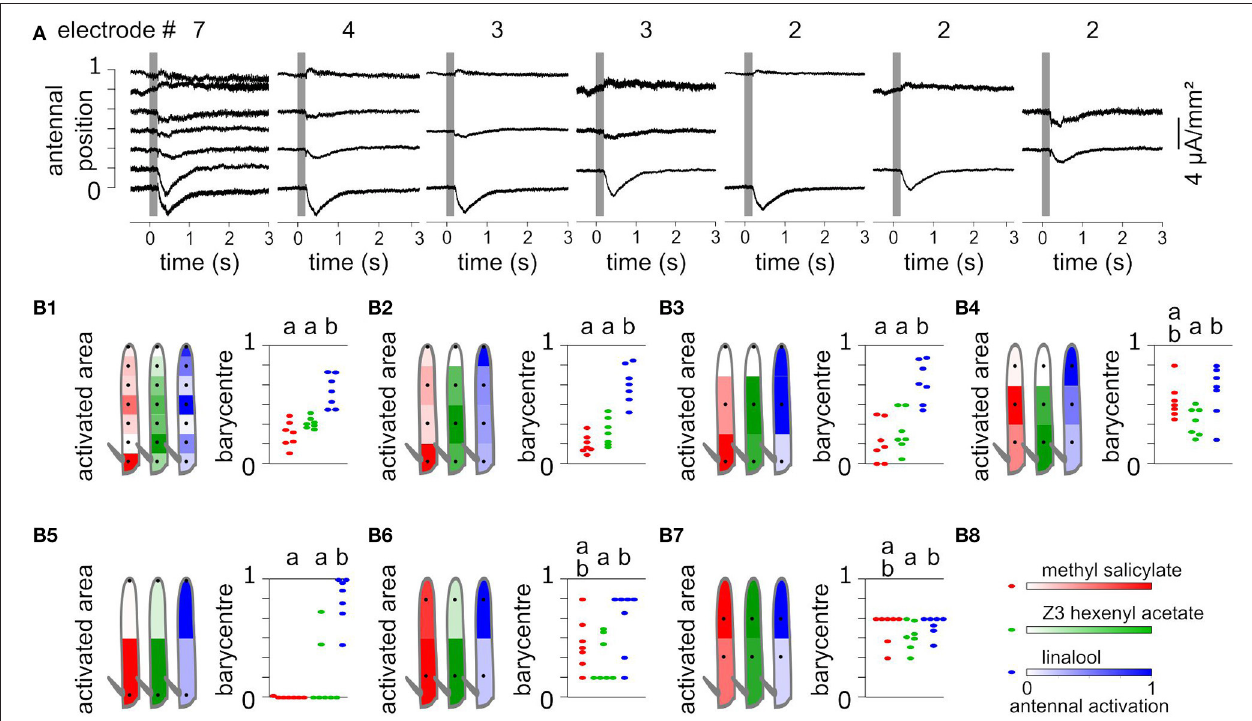
FIGURE 5 | Spatial information collected from different numbers of recordings. (A) CSD responses to Z3-hexenyl acetate were estimated from the same individual as in Figures 2A,B . The CSD were estimated from 2, 3, 4, or 7 electrode recording positions. In each case, the CSD responses were horizontally aligned with the considered recording positions. (B) Each subpanel (B1–B7) shows the CSD responses of Z. cucurbitae to puffs of methyl salicylate (red), Z3-hexenyl acetate (green) and linalool (blue) estimated with a different subset of recordings. The subset included seven (B1) , four (B2) , three (B3,B4) , or two (B5–B7) recording positions that are indicated with black dots on the drawing of the funiculus (left). The spatial CSD maps were superimposed with the drawing, and the antennal area corresponding to each compartment of the model of the funiculus is color coded with the estimated CSD averaged over seven individuals. Subpanel (B8) shows the color scale in normalized CSD units. The scatter plot on the right shows the spatial center of mass of the CSD map calculated for each individual. An artificial jitter was added on the X-axis to distinguish the dots. For each subset of recordings, the center of masses that differ significantly are labeled with a different letter above the plot (paired Wilcoxon’s test, p <